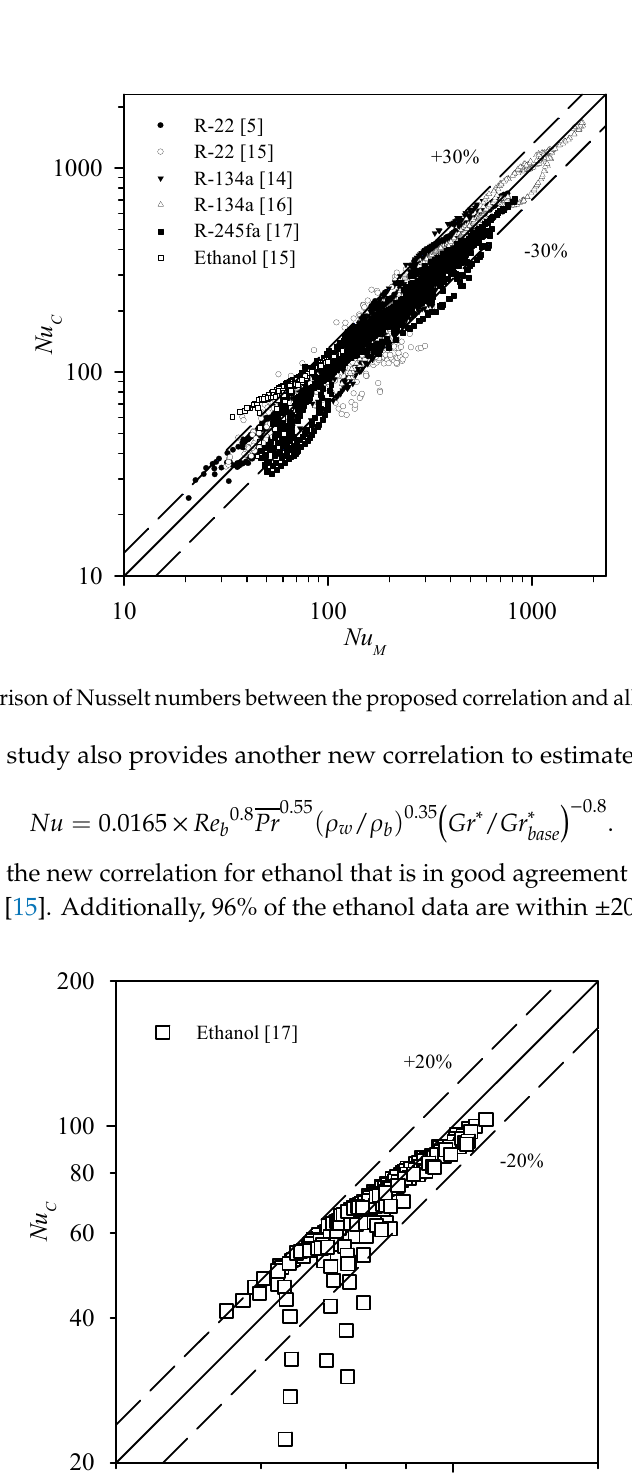
Figure 12. The comparison between the measured and calculated Nusselt number for ethanol.